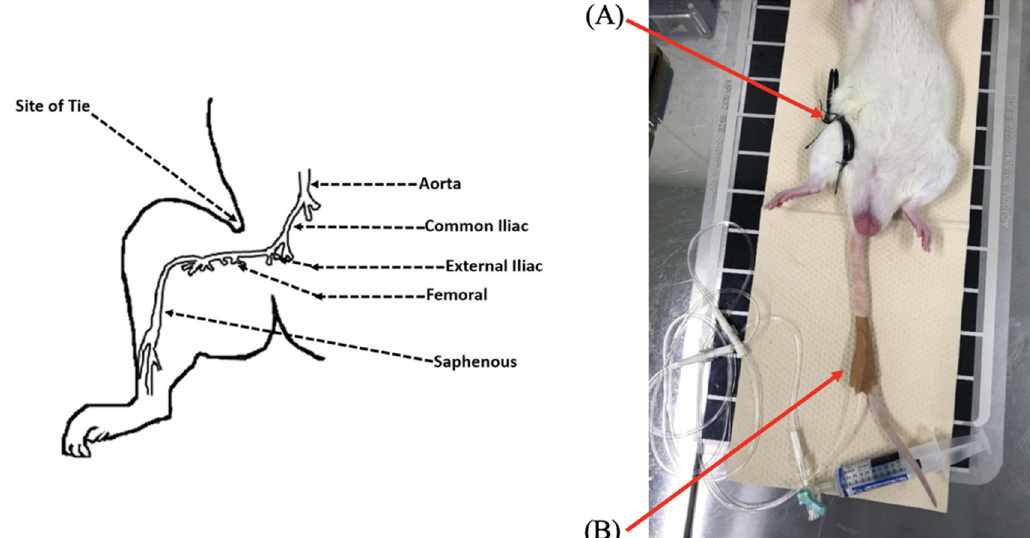
Figure 1. Fastened zip-tie rat model of acute compartment syndrome. Creation of an ACS model of the entire right lower limb by wrapping a zip tie around the rat’s right inguinal region. ( A ) The site of the zip tie. ( B ) The arterial line for blood sample collection. An arterial line was placed in the caudal ventral artery and set up so that blood could be sampled at any time.